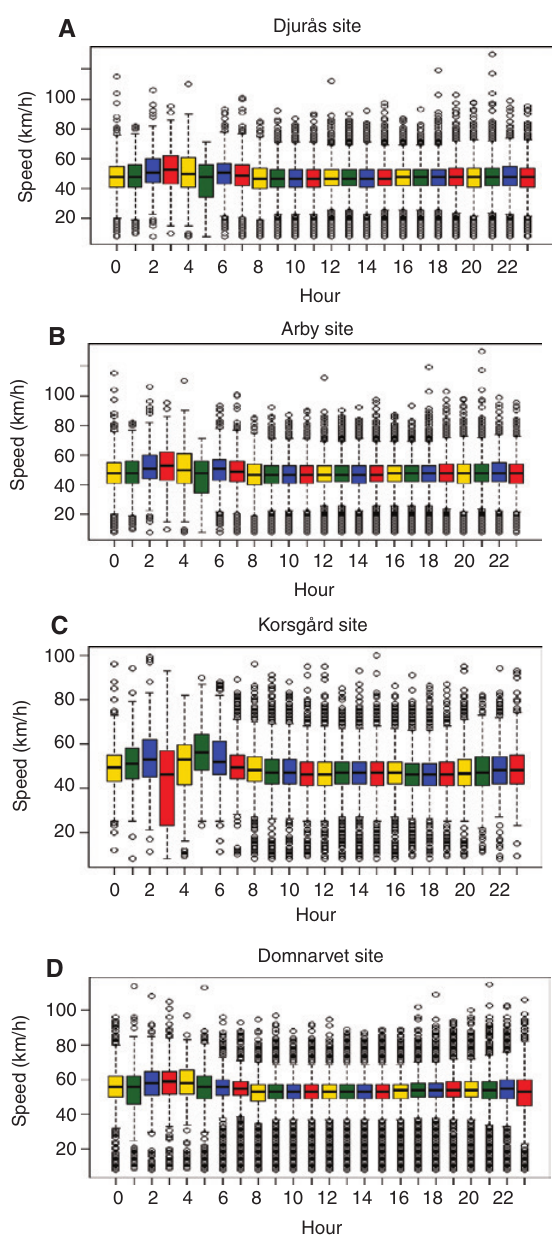
Figure 3: Boxplot Comparisons for Each Hour of the Day of the Four Test Sites: (A) Site-1, (B) Site-2, (C) Site-3, and (D)